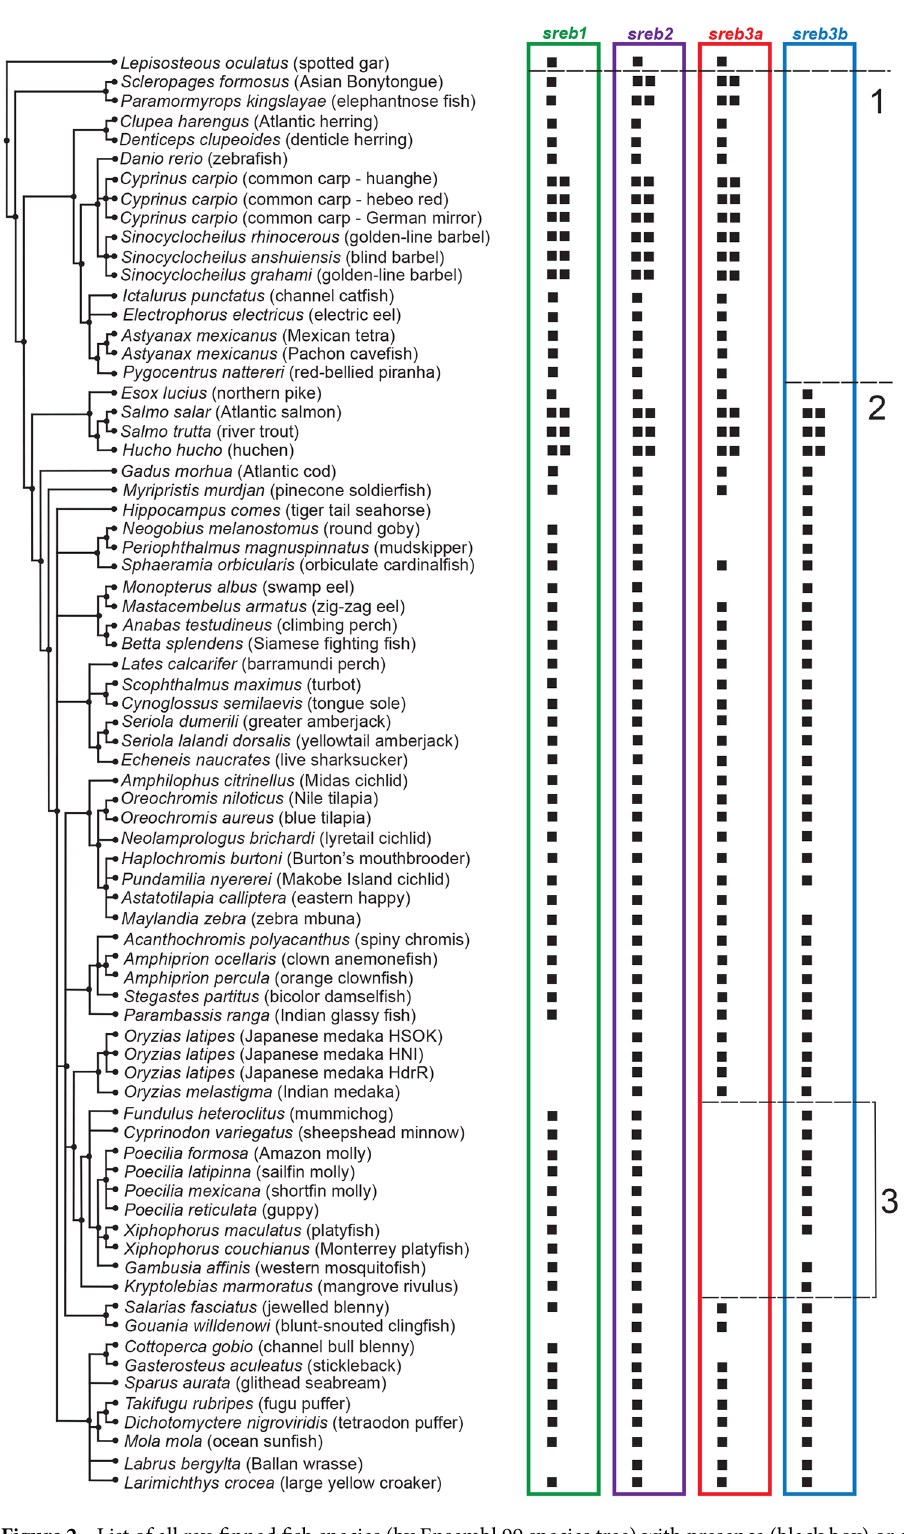
Figure 2. List of all ray-finned fish species (by Ensembl 99 species tree) with presence (black box) or absence (open space) of any unique genomic location with significant similarity to Danio rerio sreb1 , sreb2 , or sreb3a genes (green, purple, and red, respectively). Sequences with greatest similarity to the novel sreb3b were also sorted (blue, see Fig. 1). Dotted lines correspond to: (1) the teleost-specific whole genome duplication event, (2) the first detection of sreb3b across fish evolution, and (3) the absence of sreb3a in Order Cyprinodontiformes (bracketed